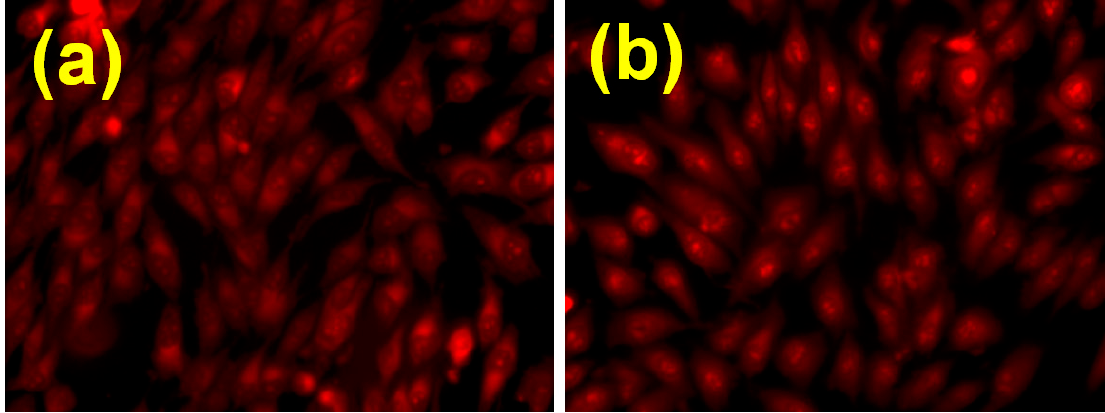
Figure 5. Human endothelial cells (EAhy926 cell line) after 72 h of growth on control ( a ) and coated surfaces ( b ).